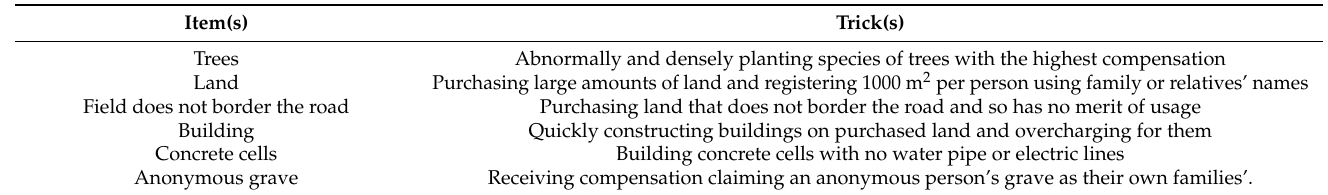
Table 1. ROK’s Common Methods of Speculation.